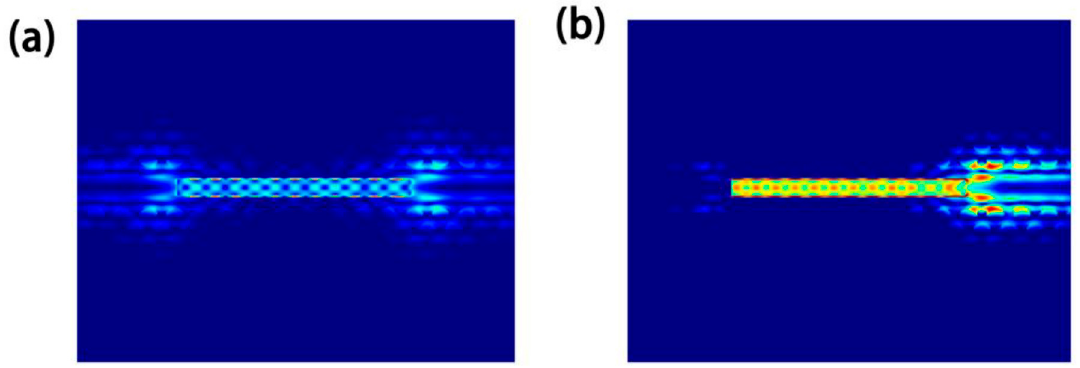
Figure 5. Normalized field intensity profiles of HE11 x mode for the ( a ) PhC NW and ( b ) PhC-DBR NW laser with a radius of 170 nm.